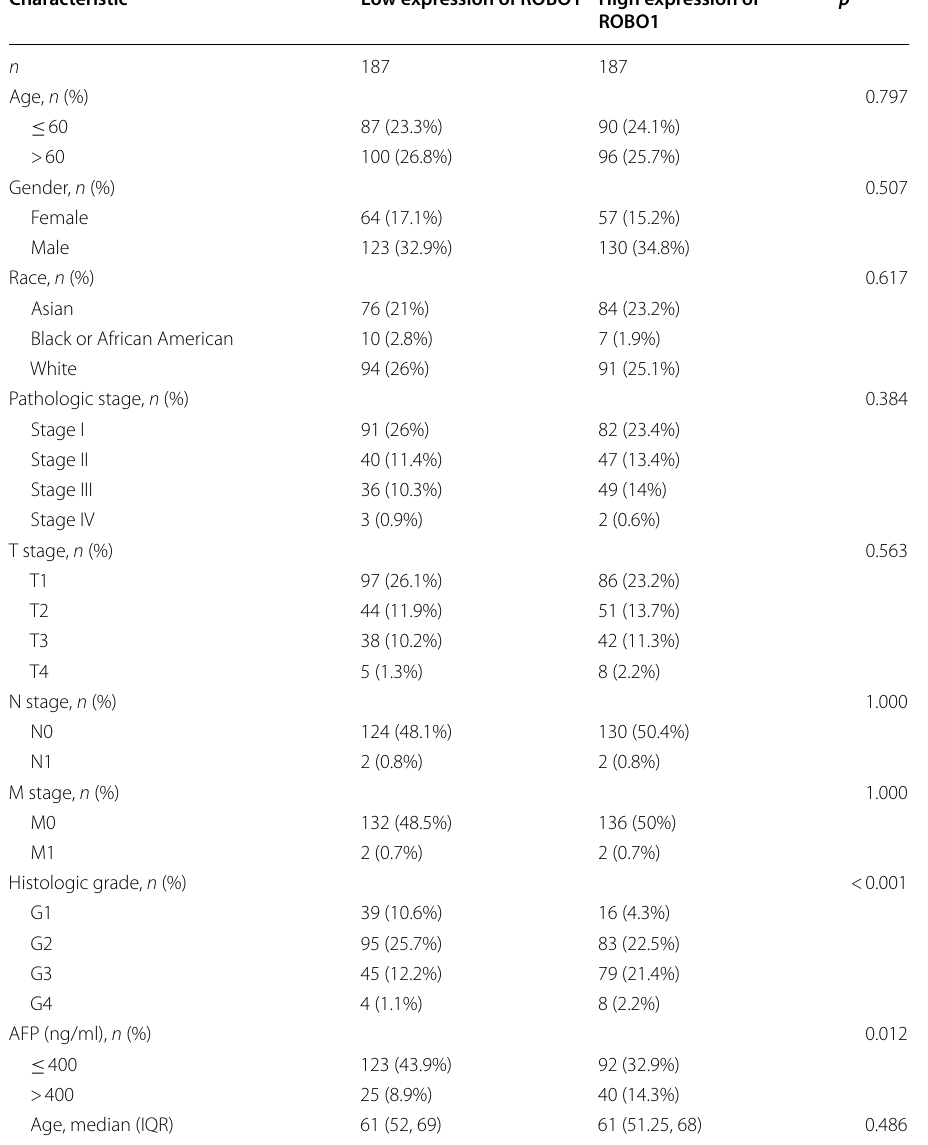
Table 1 The association of ROBO1 expression with clinical parameters in HCC patients Characteristic Low expression of ROBO1 High expression of